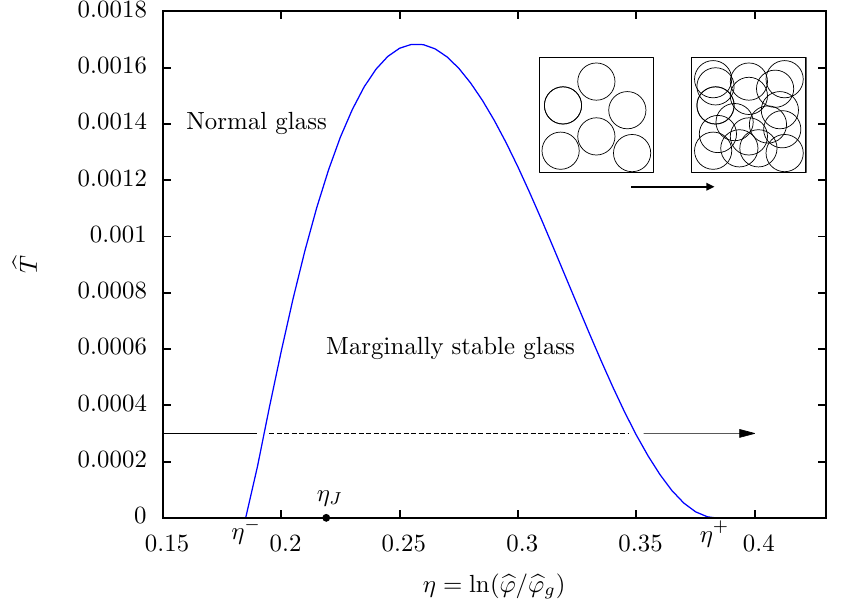
ϕ = 8. The island (cid:98) g